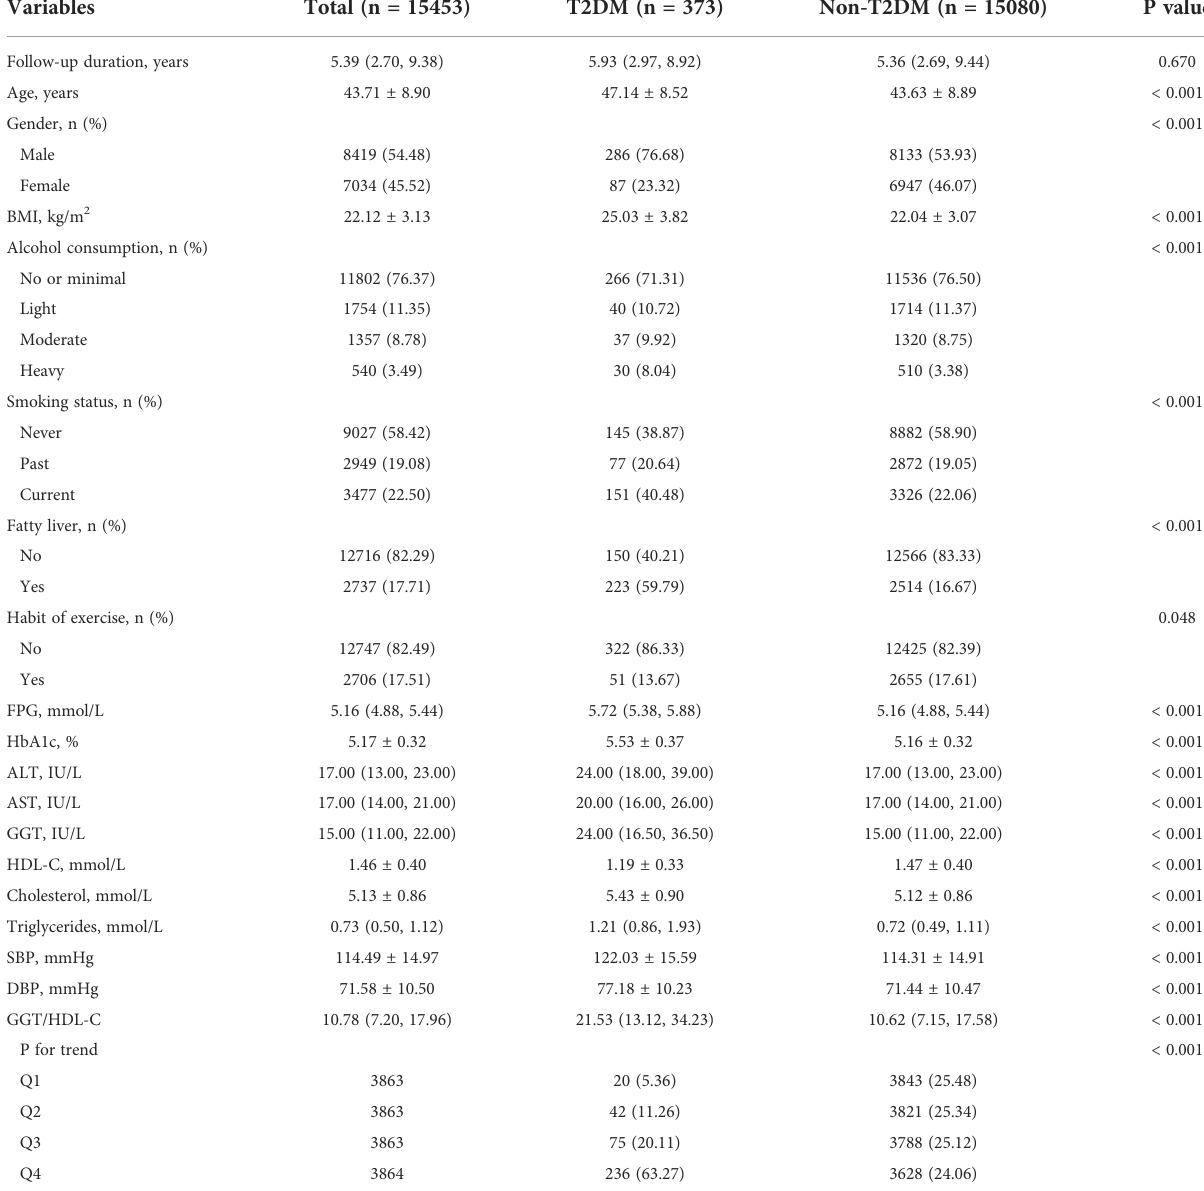
TABLE 1 Baseline characteristics of the study